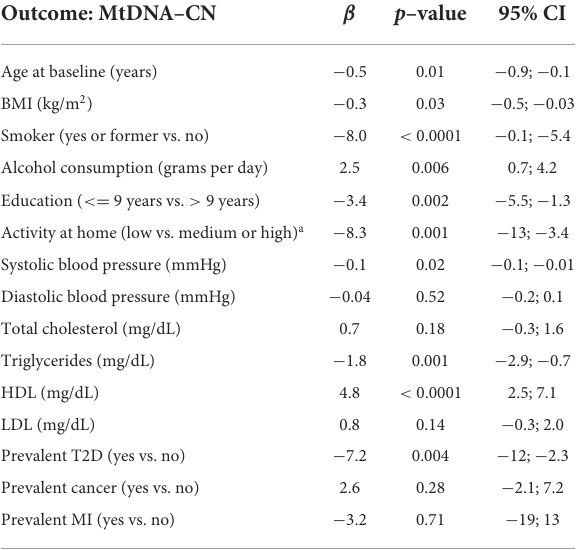
TABLE 2 Univariate linear regression models examining association between mtDNA-CN and clinical risk